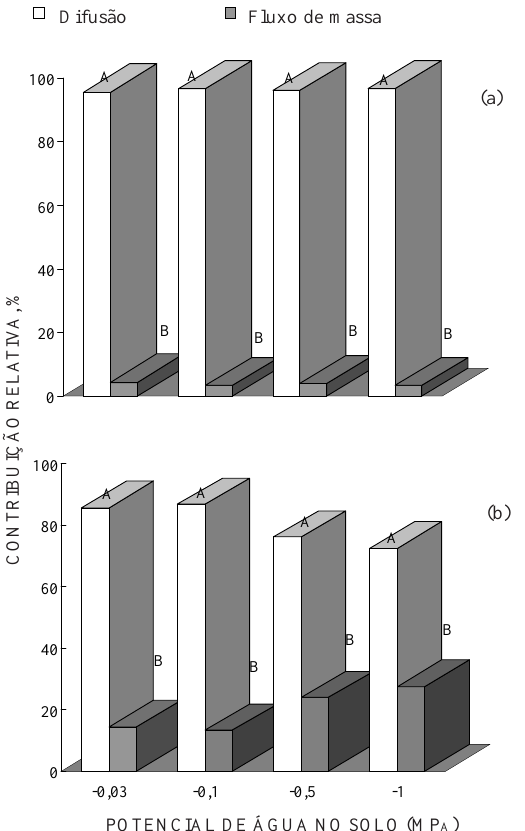
Figura 4. Contribuição percentual da difusão e do fluxo de massa na absorção de potássio, considerando a disponibilidade de água no solo e a aplicação do potássio (a: 15 mg dm -3 e b: 121 mg dm -3 ). Barras com a mesma letra não diferem entre si pelo teste de Tukey a 5